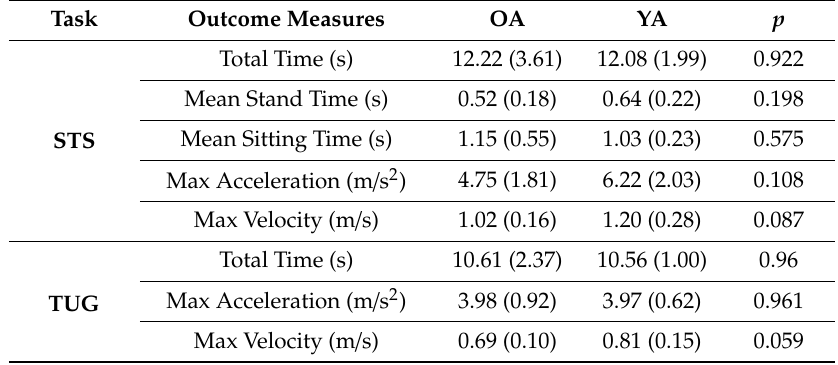
Table 3. Group di ff erences of key outcome measures (mean and standard deviation).